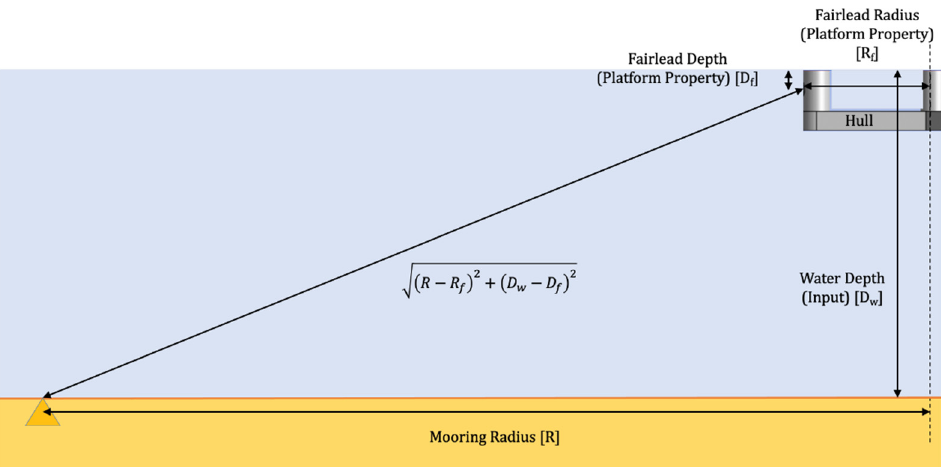
Figure 3. Geometric Feasibility Design Constraint .